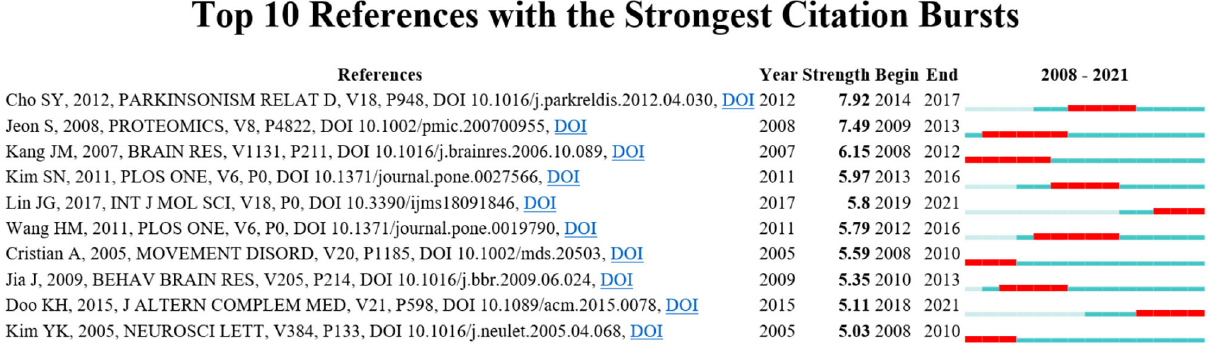
FIGURE 7 | Top 10 references with the strongest citation